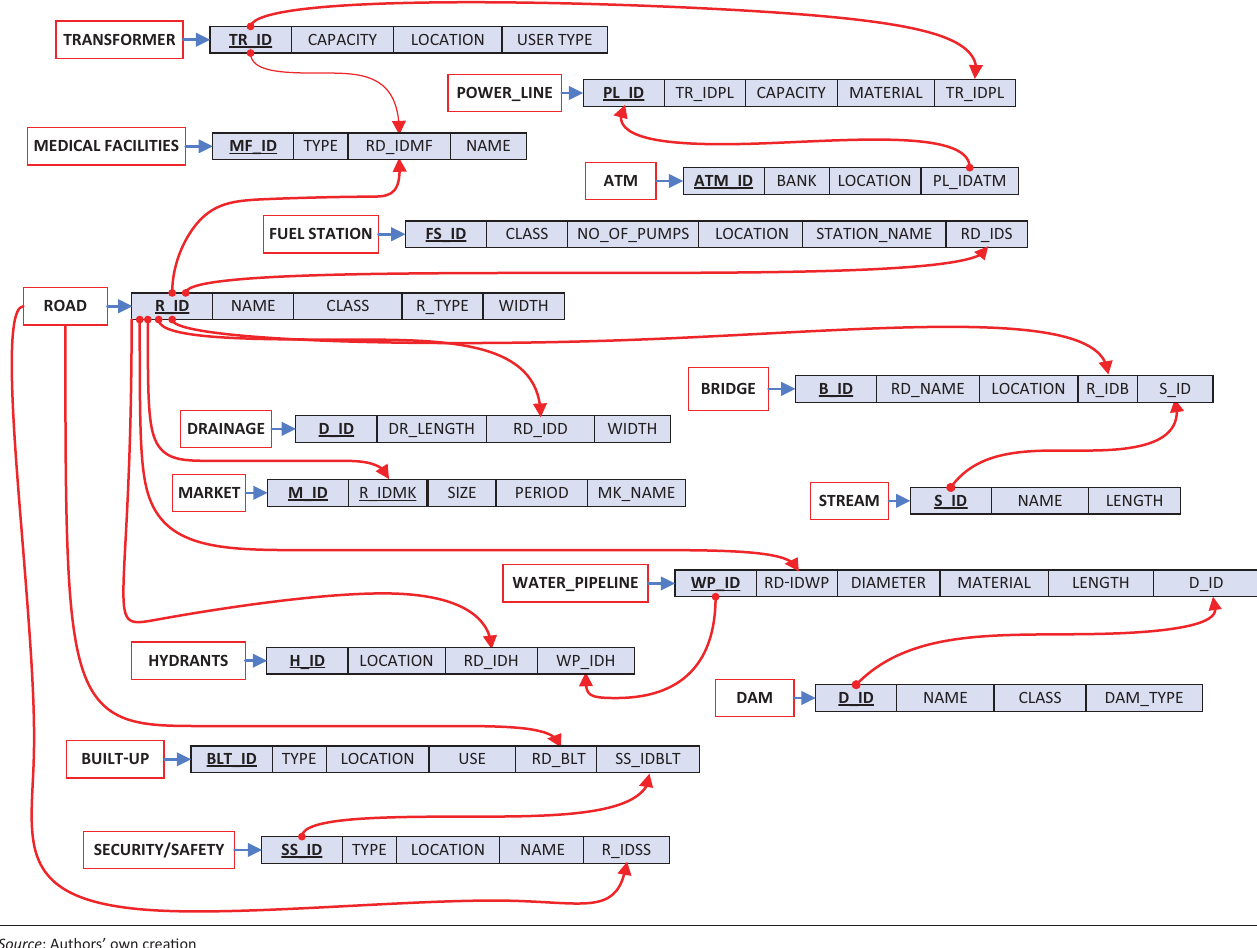
FIGURE 5: Logical model designed for urban critical infrastructure and disaster